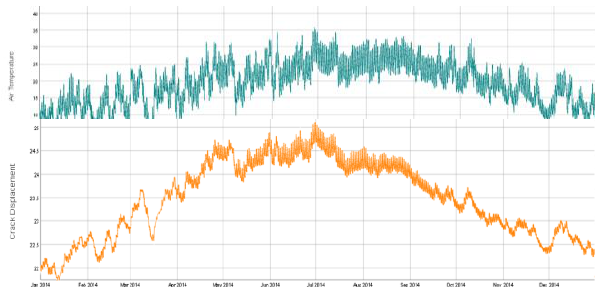
Figure 5. Air temperature trend (2015) vs. rock displacement trend measured at #6213.